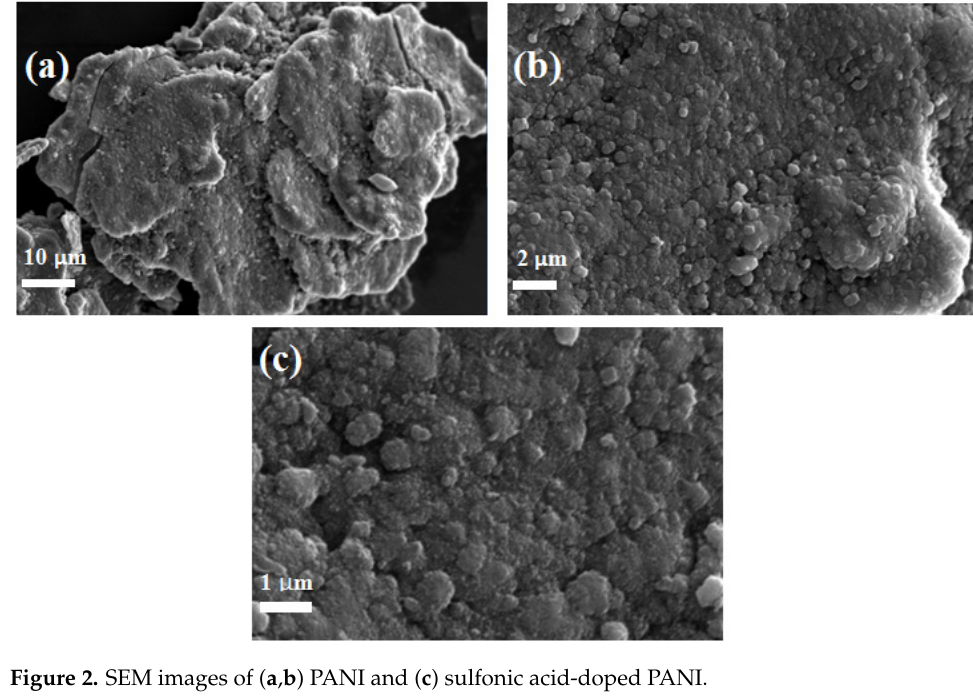
Figure 2. SEM images of ( a , b ) PANI and ( c ) sulfonic acid-doped PANI. Figure 3 shows the changes in the optical absorption spectrum after the PANI sul- fonic acid doping. It should be noted that the absorption spectrum of pure PANI exhibits four absorption bands situated at 207 nm, 219 nm, 252 nm and 286 nm. According to the literature [42], these bands are, respectively, attributed to σ – σ *, σ – π *, π – σ * and π – π * tran- sitions. After acid doping, the absorption spectrum is strongly affected. Principally, we show the creation of a new absorption band at 387 nm, supporting the optical gap reduc- tion. This broad band is the consequence of the transformation of PANI from leucomer- aldine form to the emeraldine salt/base forms [43], which agrees well with FTIR results. Therefore, the newly created optical transition is the consequence of a new energetic level in the PANI band gap [44]. A similar effect has been already observed for HCl-doped PANI [45].